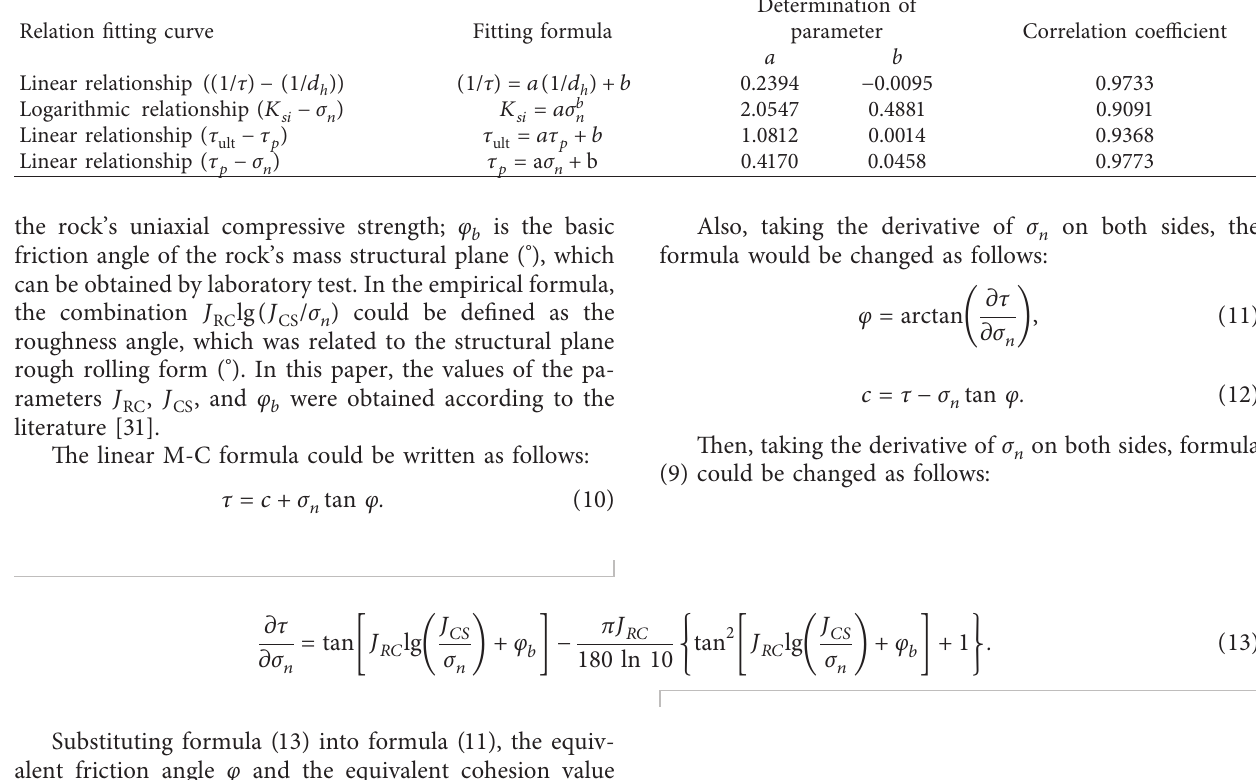
Determination of parameter Correlation